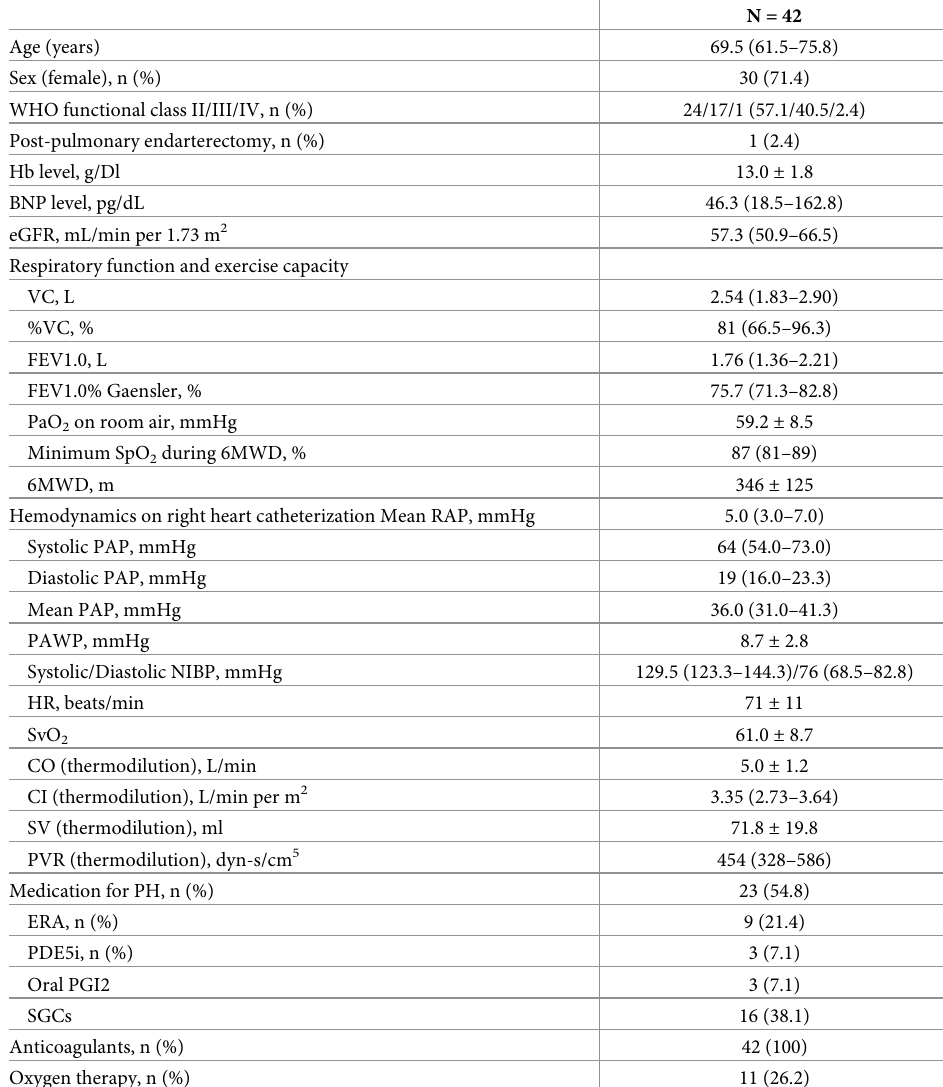
Table 1. Patient characteristics at